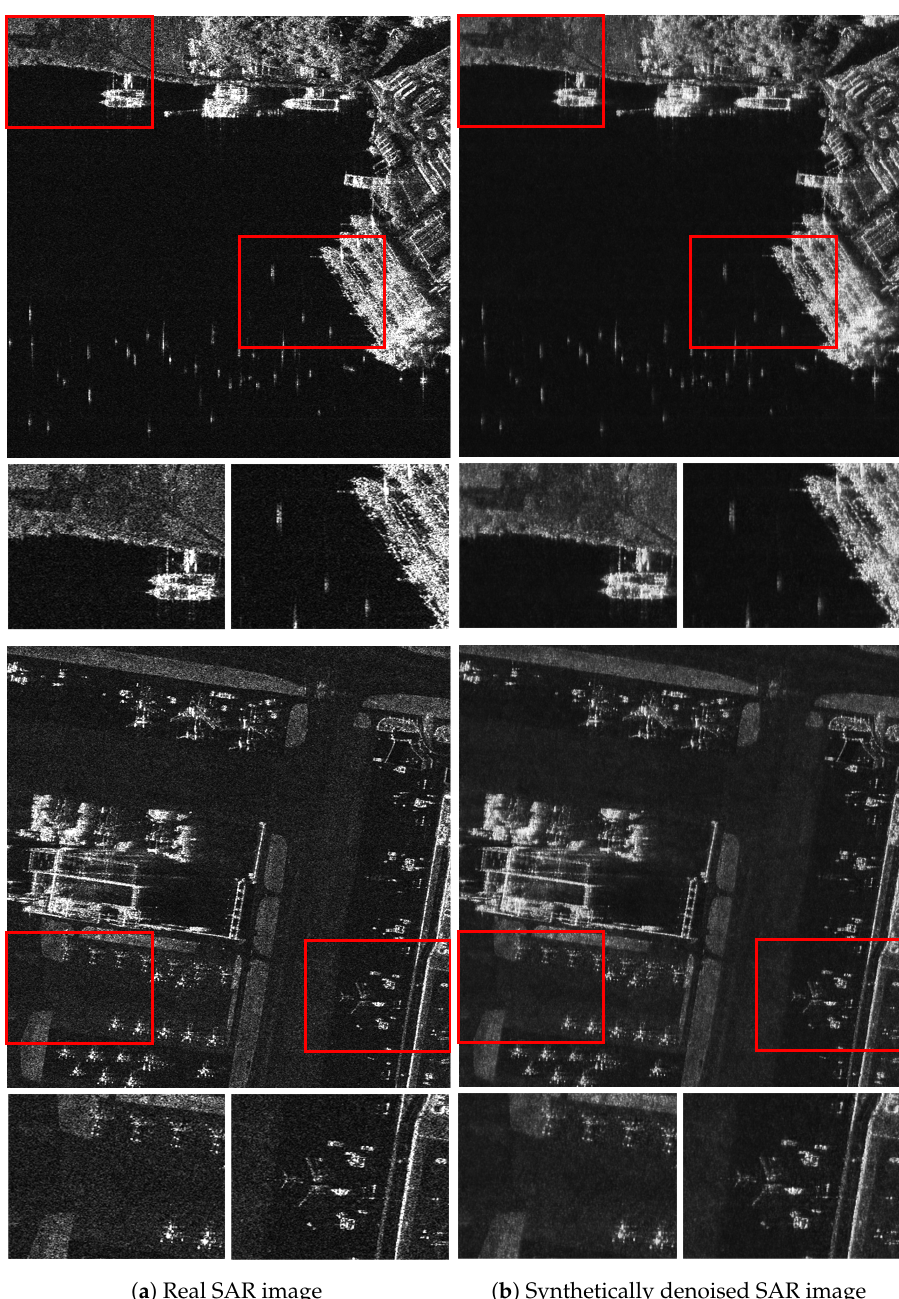
Figure 8. Two paired examples of noisy SAR (left) and despeckled SAR (right) images. Red bounding boxes for each image enlarge corresponding sub-regions. As shown in the enlarged windows, scattering waves and speckle noises are relatively less observed in denoised